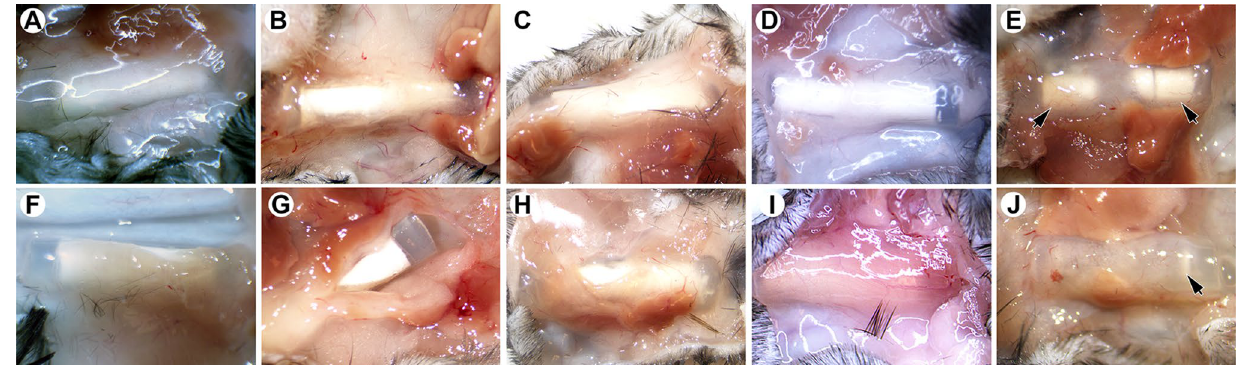
Figure 11. Images of used TAF implants at the time of excision from C57BL/6 J mice; ( A – E ), low-releasing; ( F – J ) high-releasing; ( A and F ), Day 3; ( B and G ), Day 7; ( C and H ), Day 14; ( D and I ), Day 21; and ( E and J ), Day 28; arrowheads identify TAF microtablets on study Day